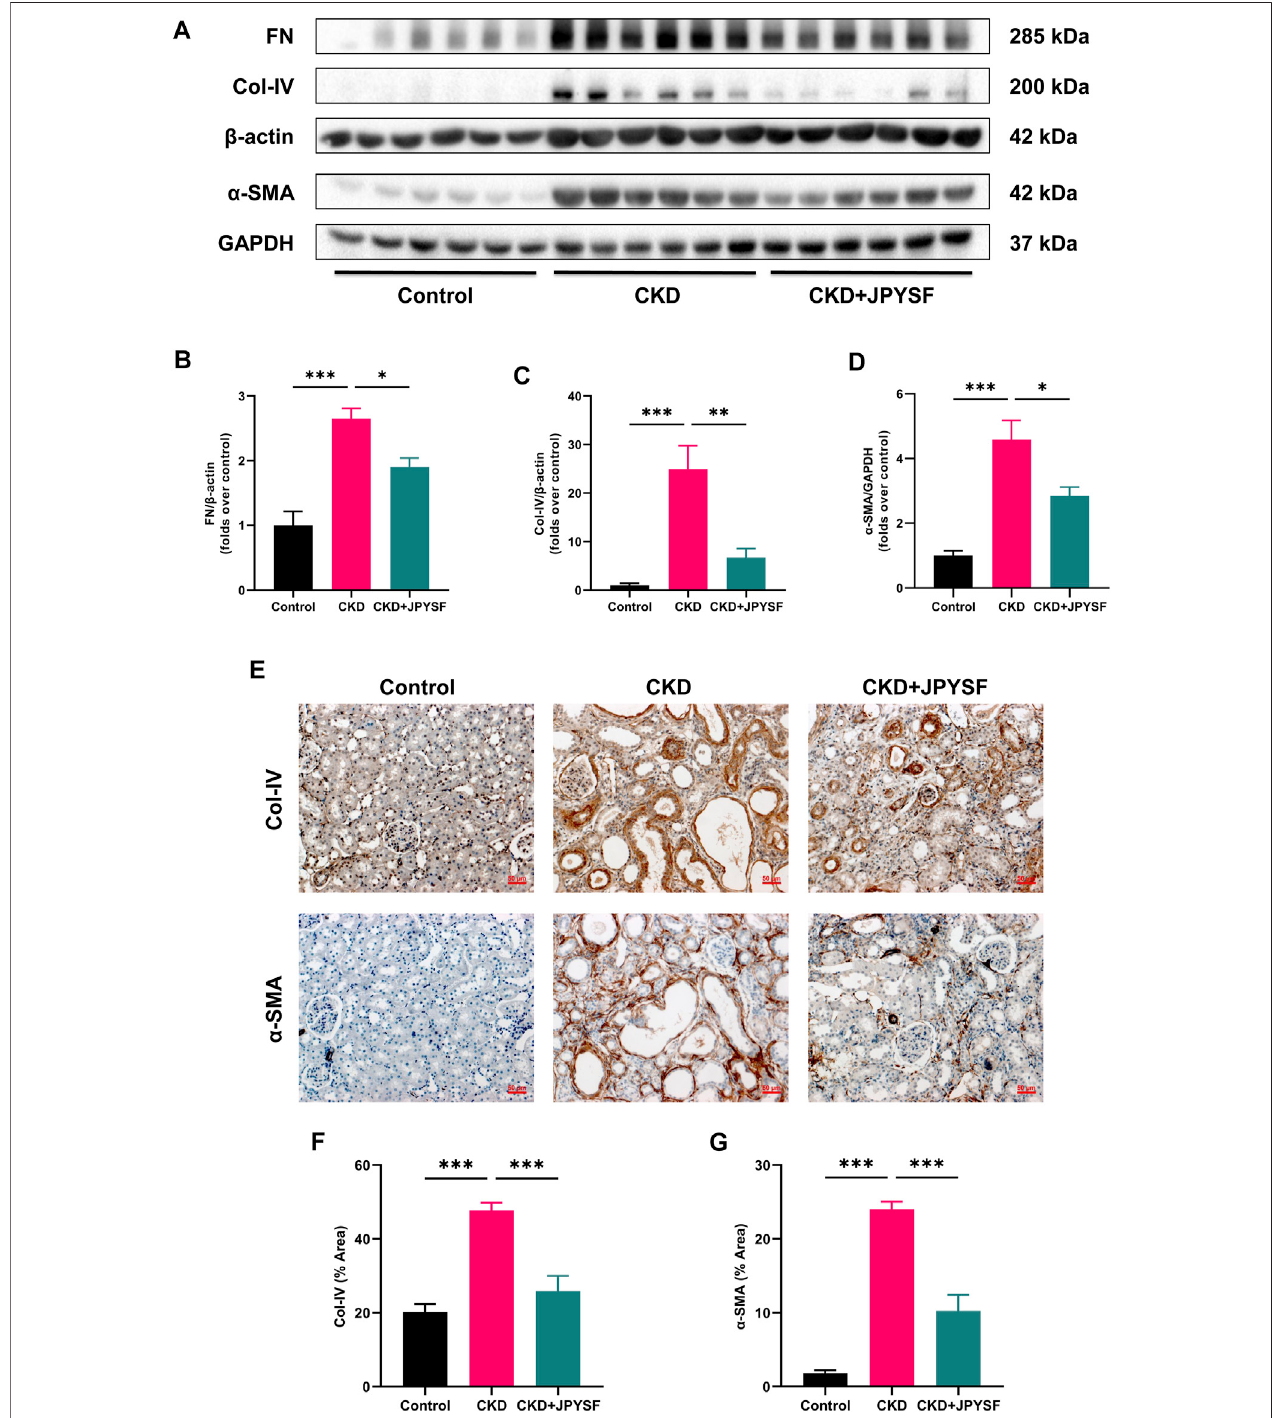
FIGURE 2 | Effects of JPYSF on renal fi brosis in adenine-induced CKD rats. (A) Representative Western blot images of FN, Col-IV, and α -SMA expression in the kidneys of rats. (B – D) Densitometric analysis of FN, Col-IV, and α -SMA normalized to β -actin or GAPDH content ( n = 6). (E) Representative immunohistochemistry images of Col-IV and α -SMA expression in the kidneys of rats. All images are shown at identical magni fi cation, ×200, scale bar = 50 μ m. (F,G) Quantitative analysis of positive staining areas for Col-IV and α -SMA ( n = 3). Values are expressed as mean ± SEM (* p < 0.05, ** p < 0.01, and *** p < 0.001 between the indicated two